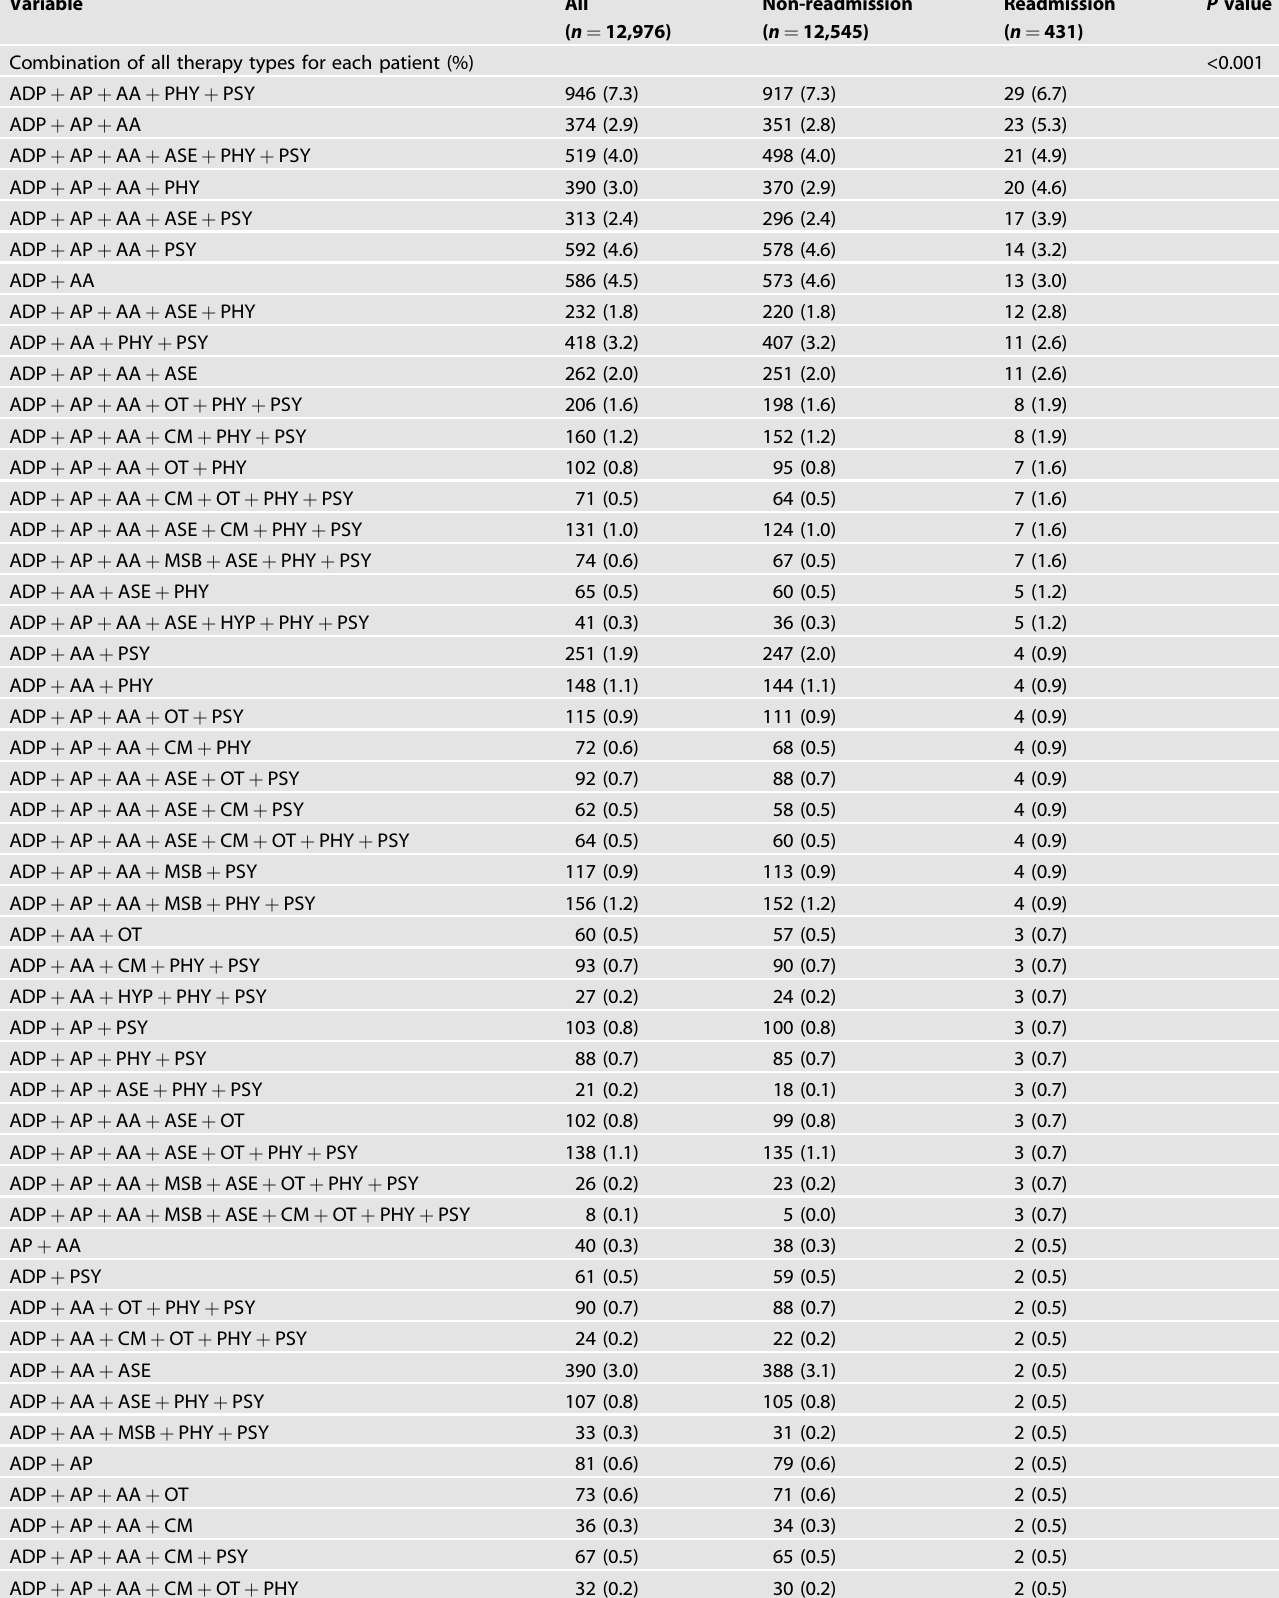
Table 3. Combination of all therapy types of the study population.